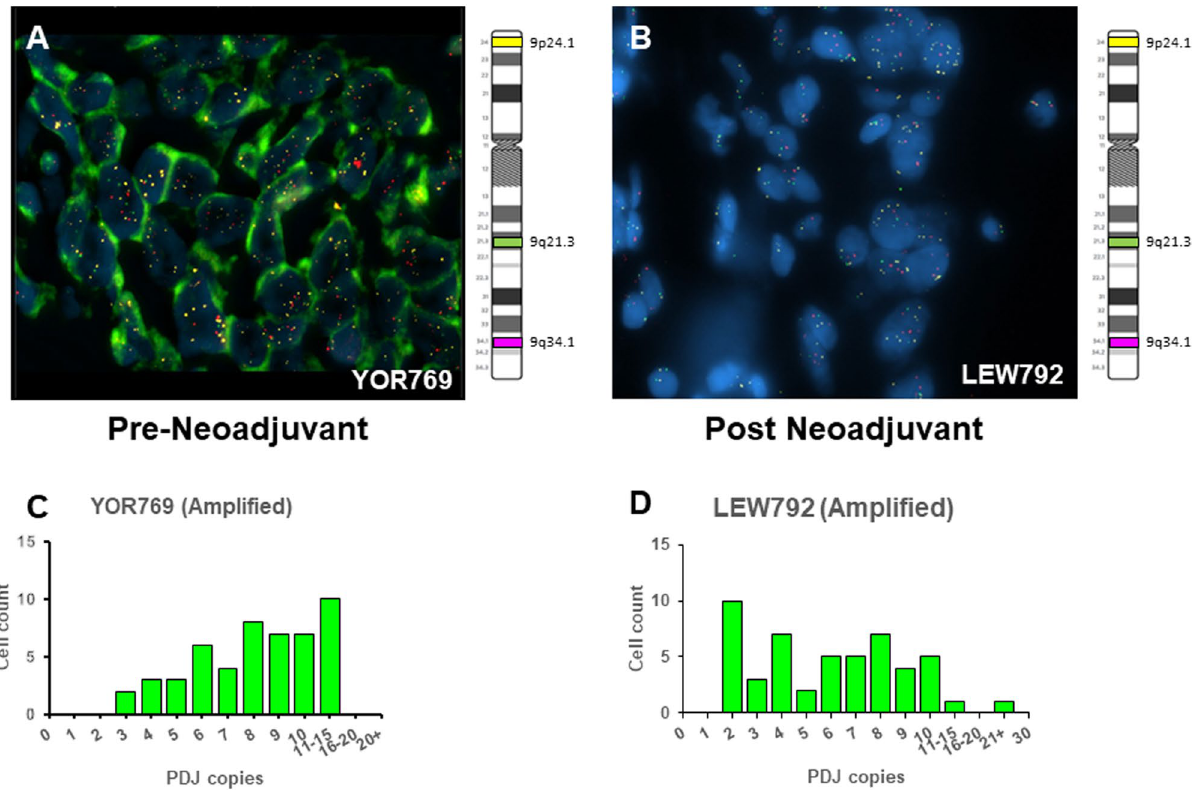
Figure 2. Distribution of PDJ amplicon copies per cell in pre and post neoadjuvant treated TNBC patient biopsies. ( A , B ) PDJ copy number was measured by FISH assay across 50 cells per sample in each TNBC biopsy. Average copy numbers ( x ) were used to define samples with deletions ( x < 2), no changes/neutral ( x = 4), gains (2 < x ≤ 4), and amplifications ( x > 4.5) of PDJ copy number. ( C,D ) Representative examples of JAK2/PDJ signals detected by fluorescence in situ hybridization (FISH) assays.